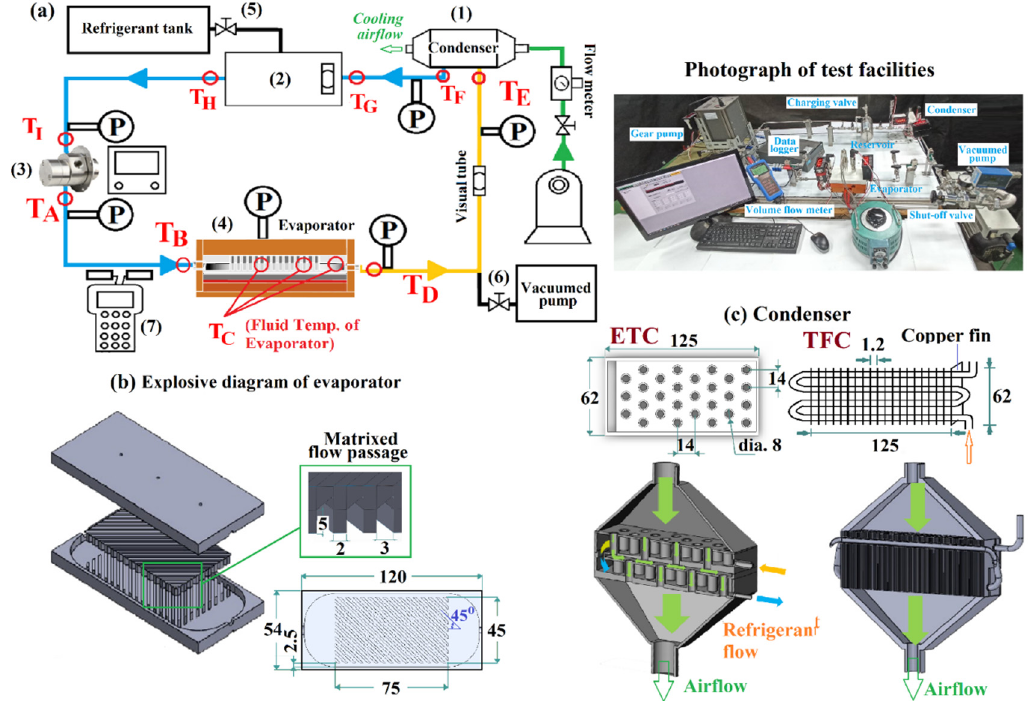
Figure 1. ( a ) pumped thermosyphon loop (1) condenser (2) saturated liquid reservoir (3) Fluid-O- Tech MG213 magnet drive gear pump (4) evaporator (5) charging valve (6) shut-off valve (7) Redstar UFT010-P ultrasonic volume flow meter. ( b ) explosive diagram of evaporator ( c ) condenser.